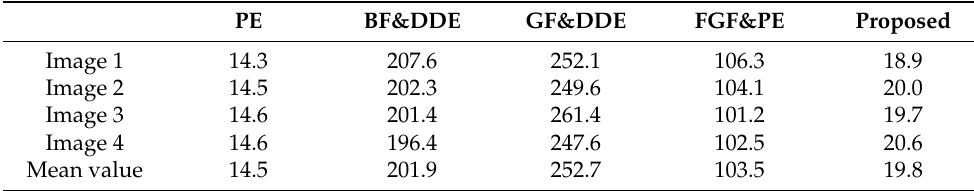
Table 5. Running time comparison of different methods (ms) .